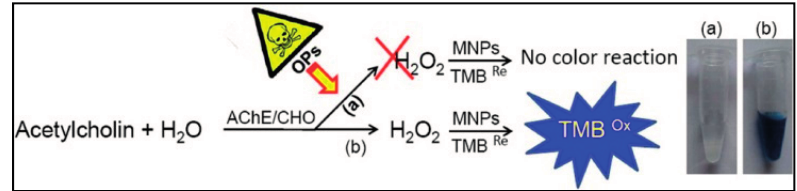
Figure 9. Sensing principle of the assay based on Fe 3 O 4 magnetic nanoparticle for OPs detection (reprinted with permission from [126]; copyright 2015 American Chemical Society).